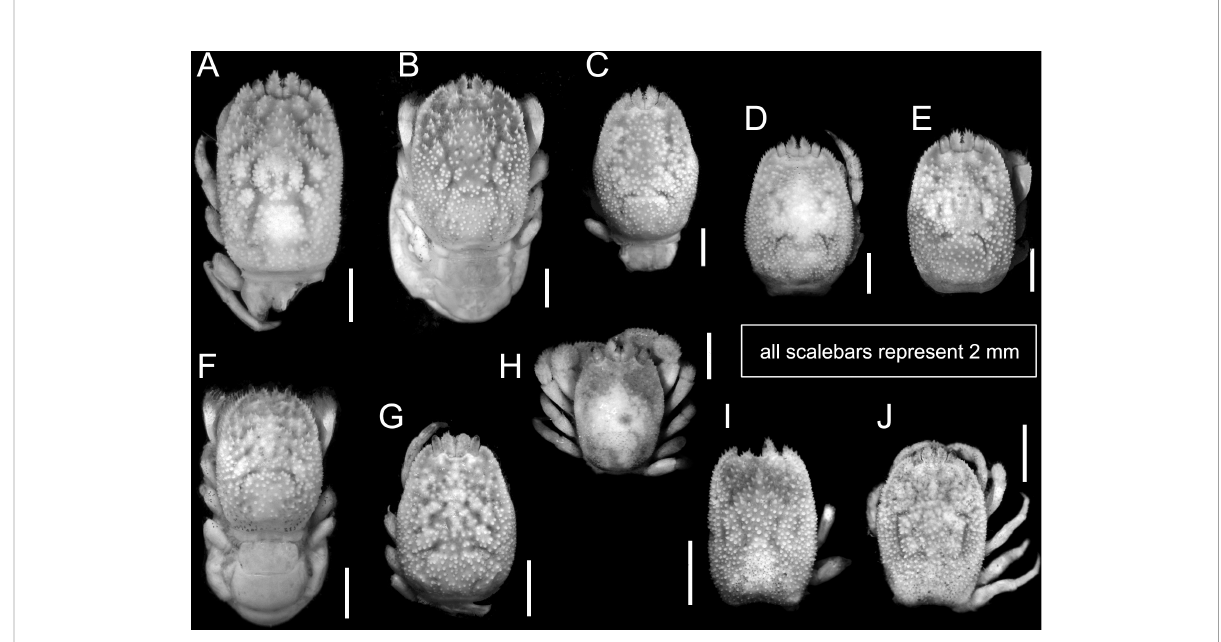
FIGURE 5 Overall habitus of recorded cryptochirids. (A) Cryptochirus coralliodytes (CEL-Hapa-022); (B, C) Lithoscaptus paradoxus (CEL-Hapa-013, 007); (D) L. doughnut sp. nov. (CEL-Hapa-040); (E) L. cf. doughnut (CEL-Hapa-006); (F – J) L. scottae sp. nov. (CEL-Hapa-037, 019, 015); (I, J) Xynomaia species (CEL-Hapa-002, 004). Carapaces of all specimens denuded. All except (H) are female